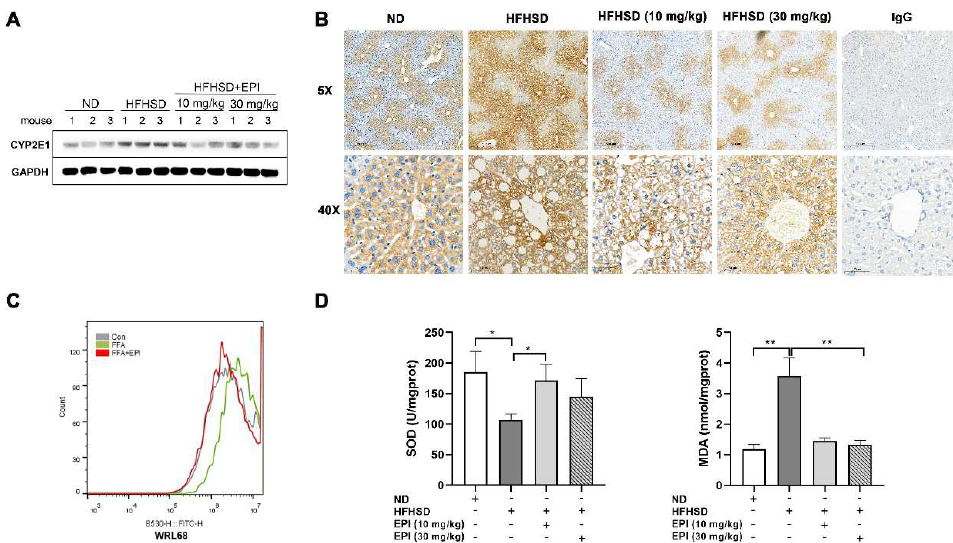
Figure 6. The effects of EPI (EPI-001) ameliorating hepatic steatosis might relate to CYP2E1 (Cytochrome P450 2E1) inhibition. ( A ) Immunoblotting analysis of CYP2E1 in mouse liver; ( B ) Repre- sentative immunohistochemical analysis showed that the expression of CYP2E1 was significantly increased in HFHSD mice, while it was decreased by EPI administration; ( C ) Fluorescence intensity of ROS (reactive oxygen species) in human hepatic cells was decreased by FCM; ( D ) The effects of EPI-001 on the contents of SOD (superoxide dismutase) and MDA (malondialdehyde) in mouse liver were detected. (mean ± SEM, * p < 0.05, ** p < 0.01). Shown are results from at least three inde- pendent experiments.